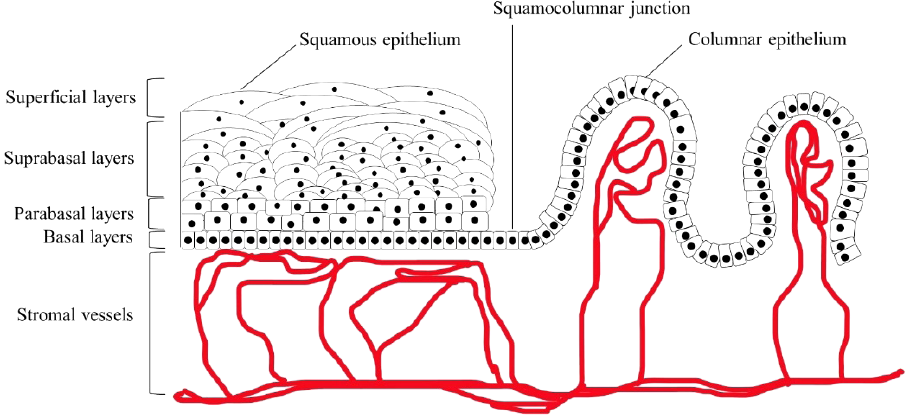
Fig. 3. Anatomy of the uterine cervix and squamocolumnar junction.